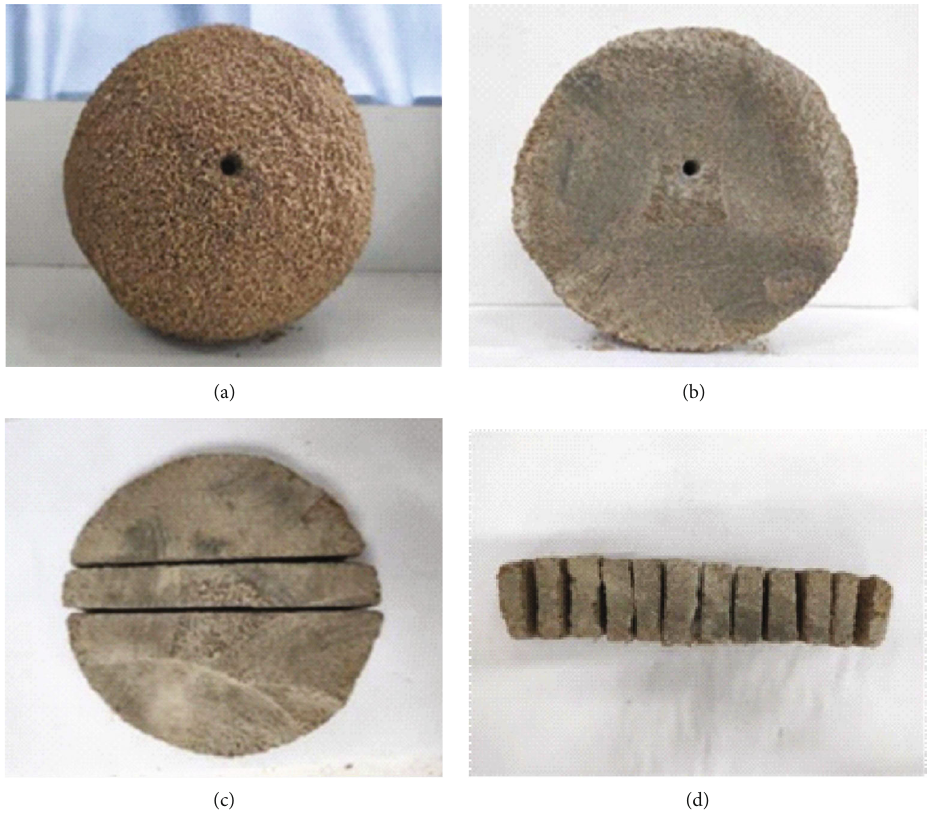
Figure 4: Samples prepared for the EDTA test: (a) cemented mass; (b) a thin pad cut from the cemented mass; (c) a strip cut from the thin pad; (d) samples made from the strip.